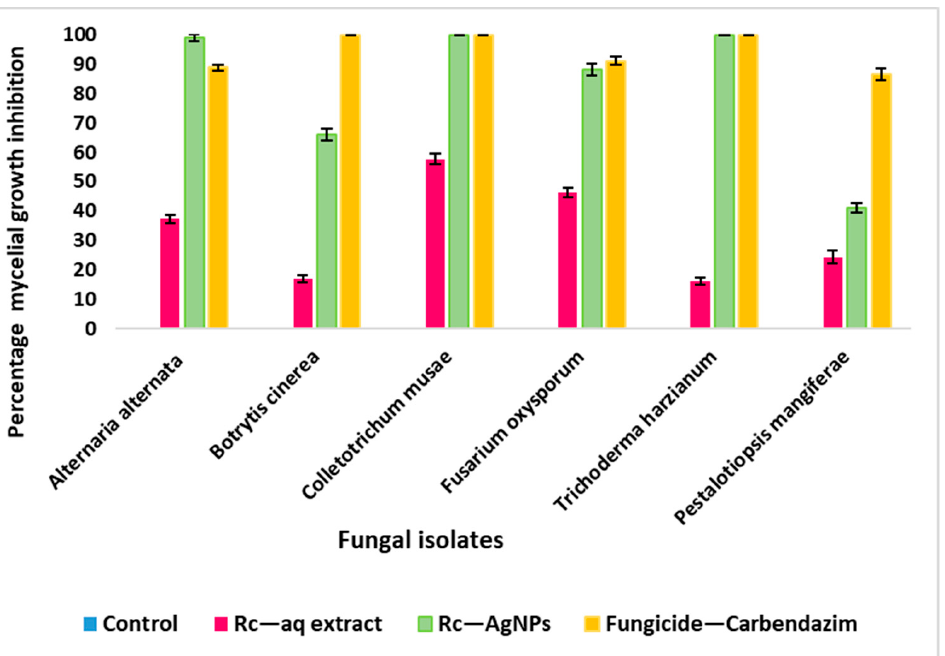
Figure 9. Percentage of mycelial growth inhibition of some fungal phytopathogens treated with red currant aqueous extracts, red currant-AgNPs, and the fungicide carbendazim (2%). The values displayed in the above graph are means of triplicate experimental replicates (±SD). Significant differences in means ( p ≤ 0.05) were determined by analysis of variance ANOVA and Turkey HSD.